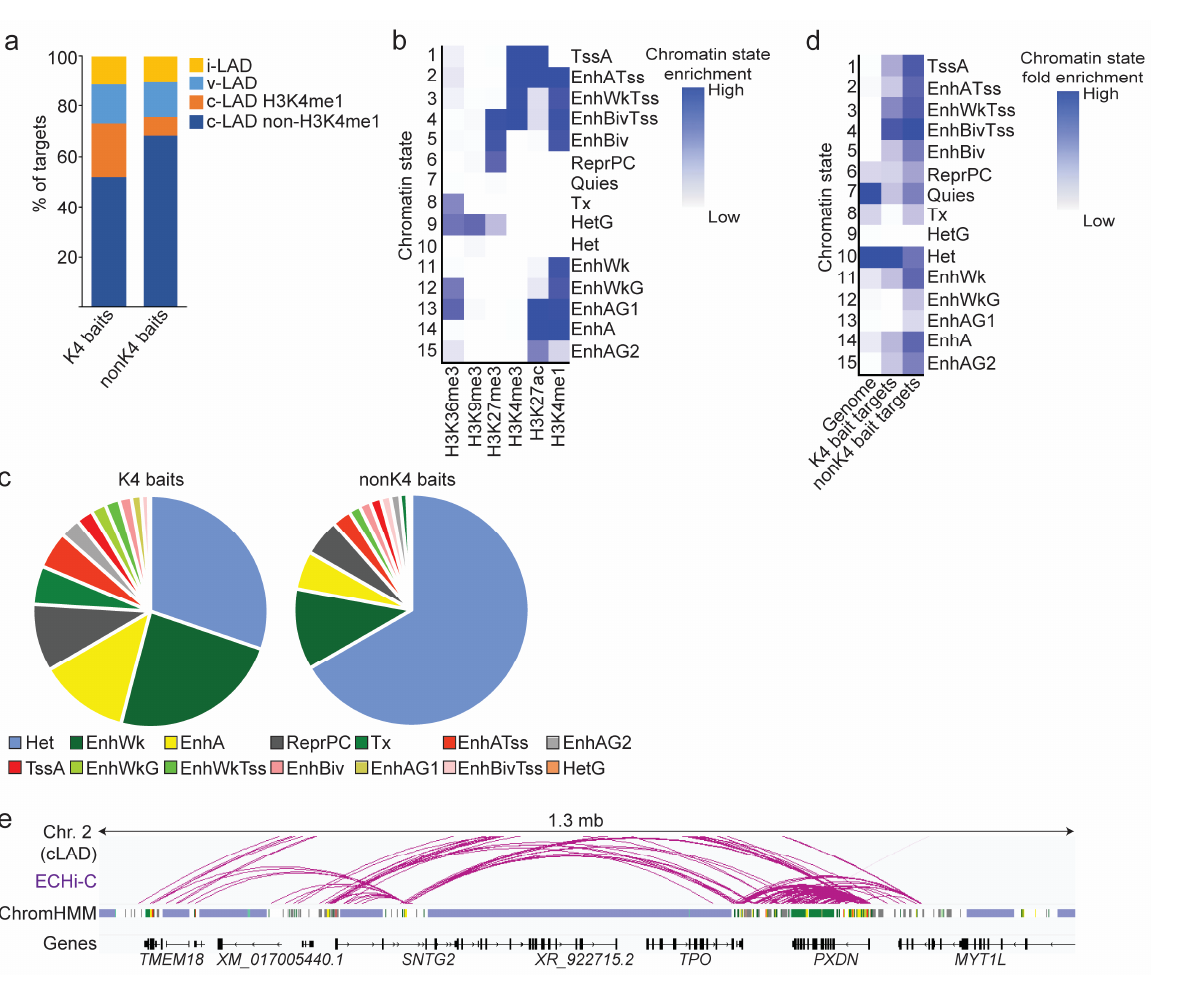
Figure 4. LAD and chromatin landscape of ECHi-C connections in cLADs. ( a ) Proportions of K4 and nonK4 bait targets in H3K4me1 peaks and non-H3K4me1 regions in cLADs, vLADs and inter-LADs (i-LAD). LAD data are from [10]. ( b ) Annotated 15-chromatin state model learned from ChromHMM in ASCs. TssA, active TSS; EnhATss, active enhancer at TSS; EnhWkTss, weak en ‐ hancer at TSS; EnhBivTss, bivalent enhancer at TSS; EnhBiv, bivalent enhancer; ReprPc, repressed